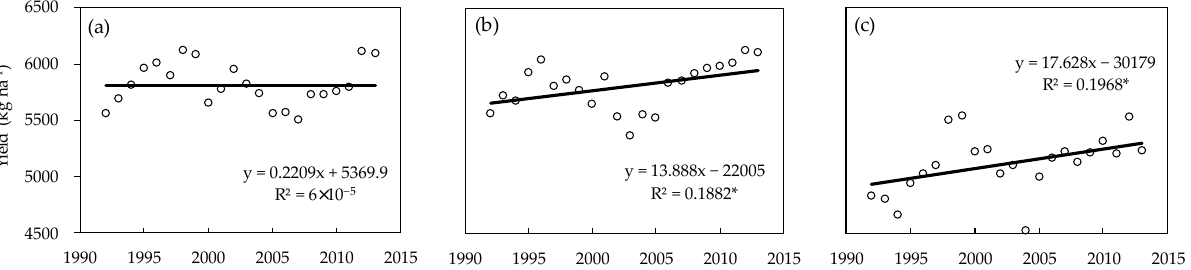
Figure 5. Trends in the yield of late rice in the three climatic zones. ( a – c ) indicate the northern subtropical zone (NST), middle subtropical zone (MST) and south subtropical zone (SST), respectively. * Significant at p < 0.05.